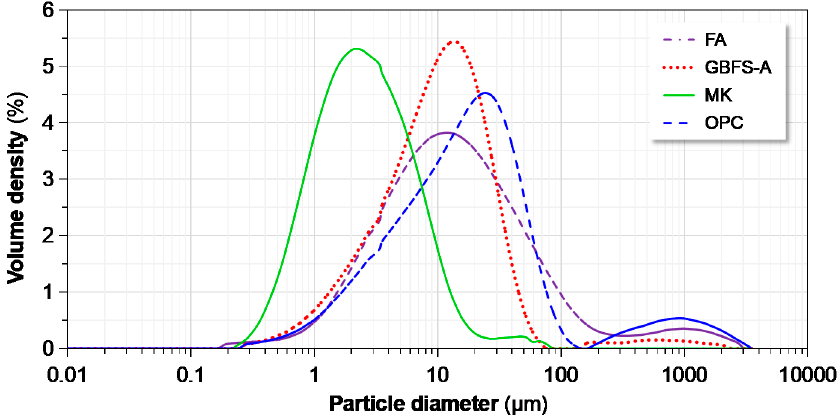
Figure 2. Particle size distributions (PSD) of the precursors employed in this study.